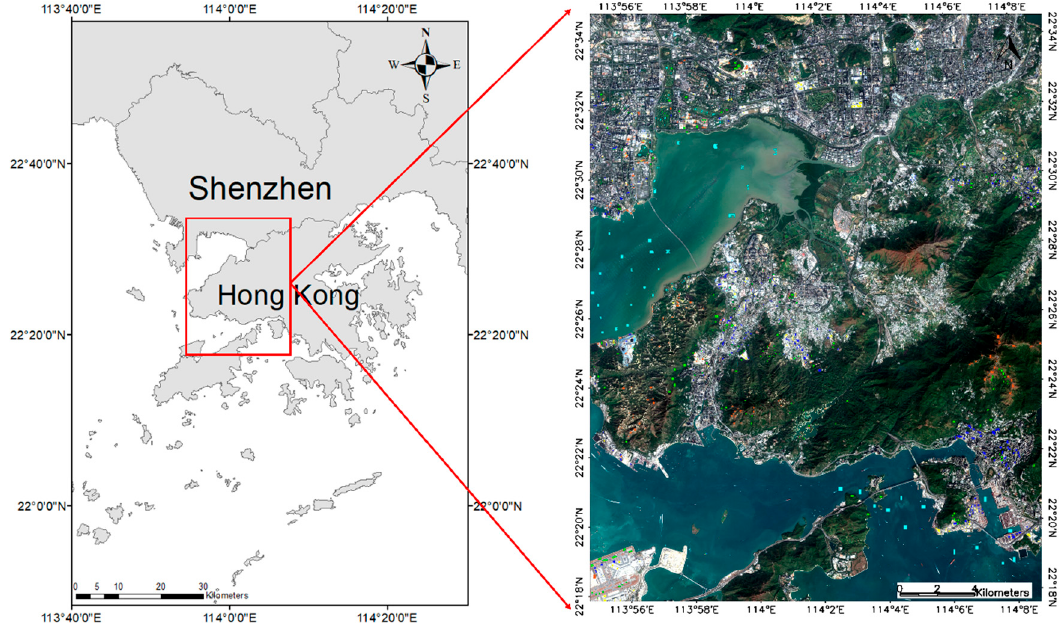
Figure 1. The geographic location of the study area.